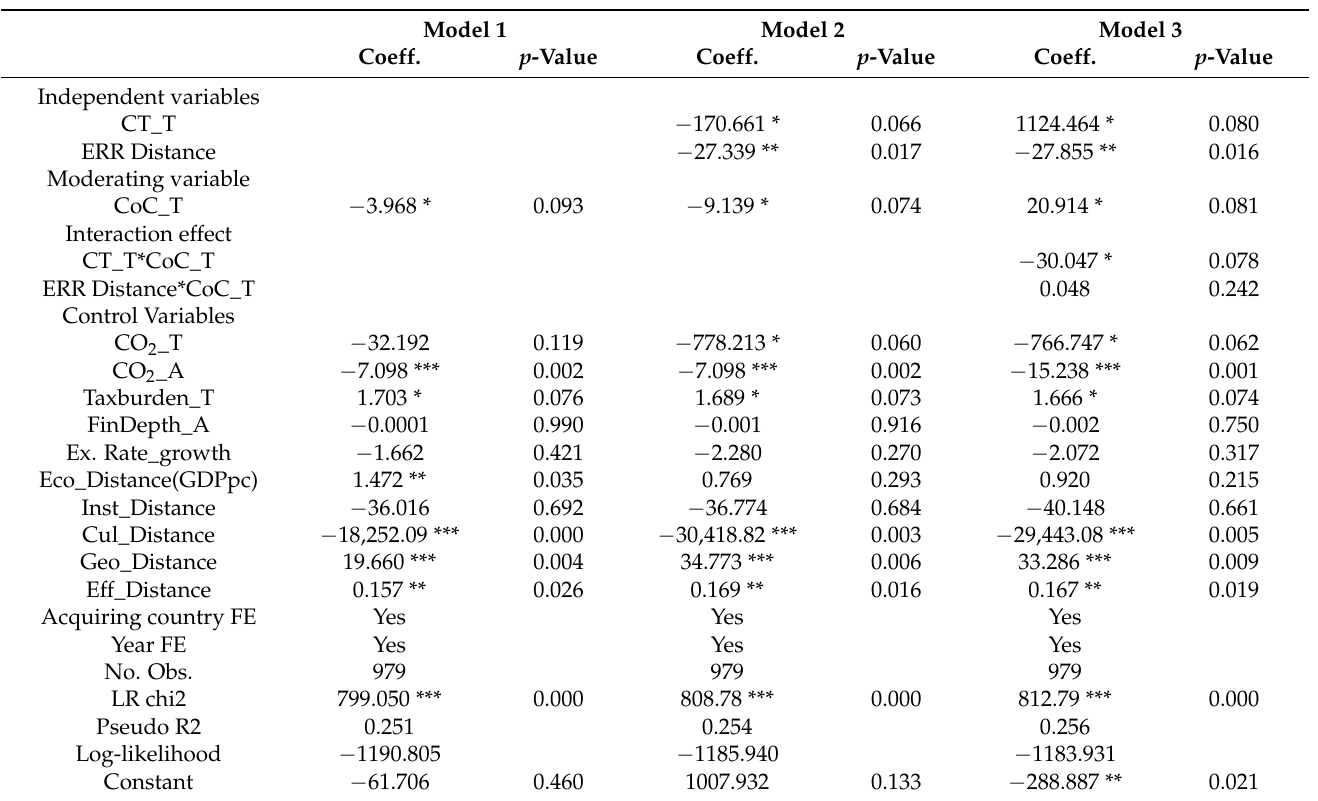
Table 4. Tobit Model results for the impact of the carbon tax and environmental regulation restriction distance on CBM&A volume and moderating effect of control of corruption of target country on the impact of independent variables on the CBM&A volume. The models include control variables showing an impact on CBM&A volume. Model 1 Model 2 Model 3 Coeff. p -Value Coeff. p -Value Coeff. p